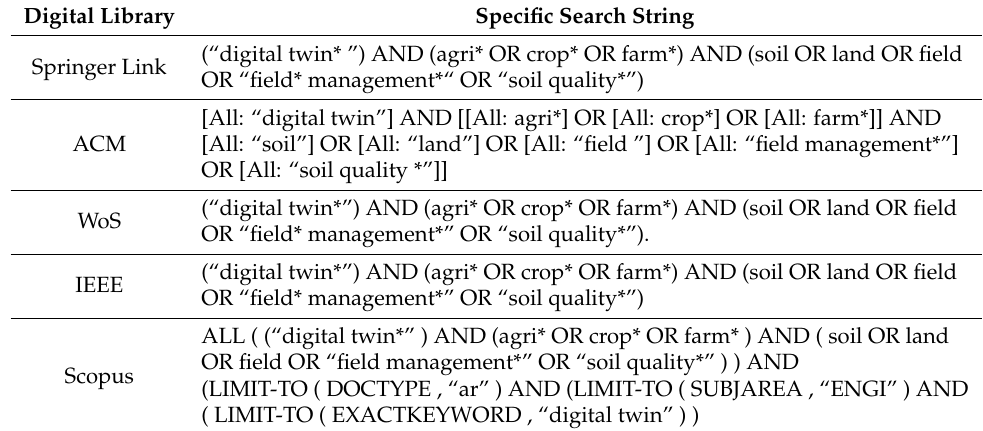
Table 8. Specific search phrases for each digital library.